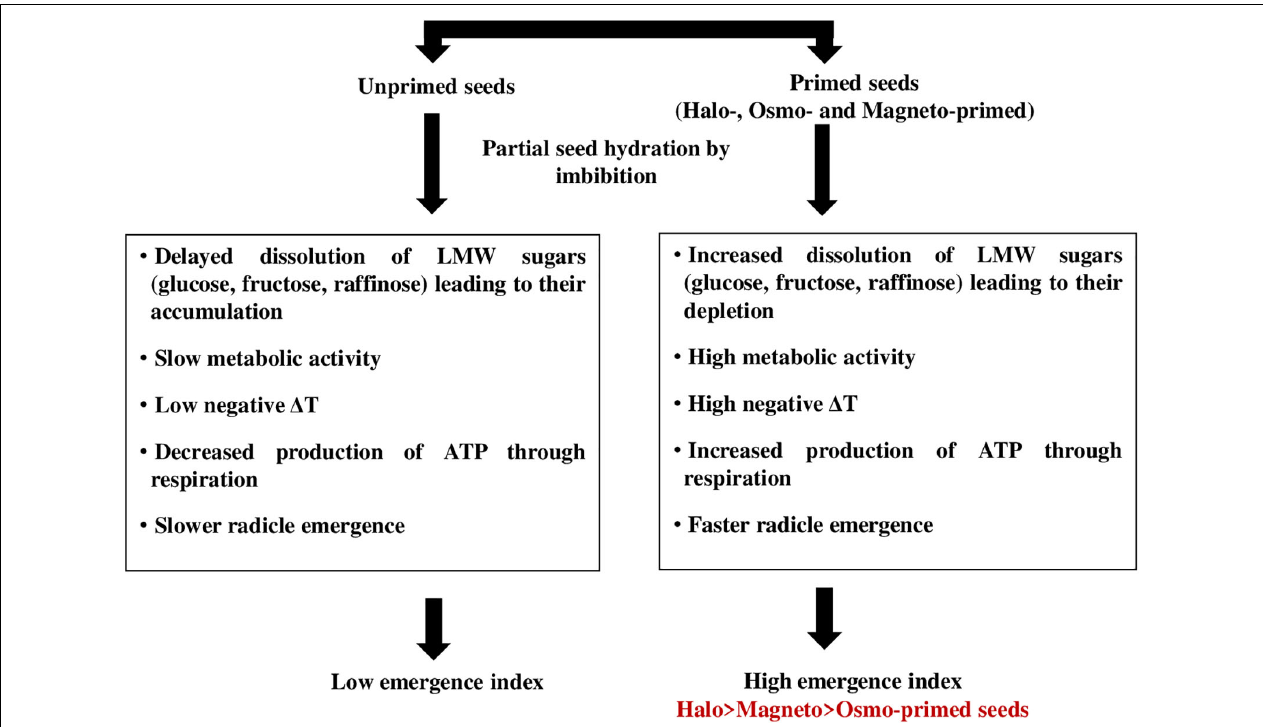
FIGURE 7 | Schematic model explaining the high emergence index of primed seed is facilitated by faster dissolution of low molecular weight sugars (Raffinose + Glucose + Fructose) resulting in more negative IR thermal temperatures in actively metabolizing seeds.